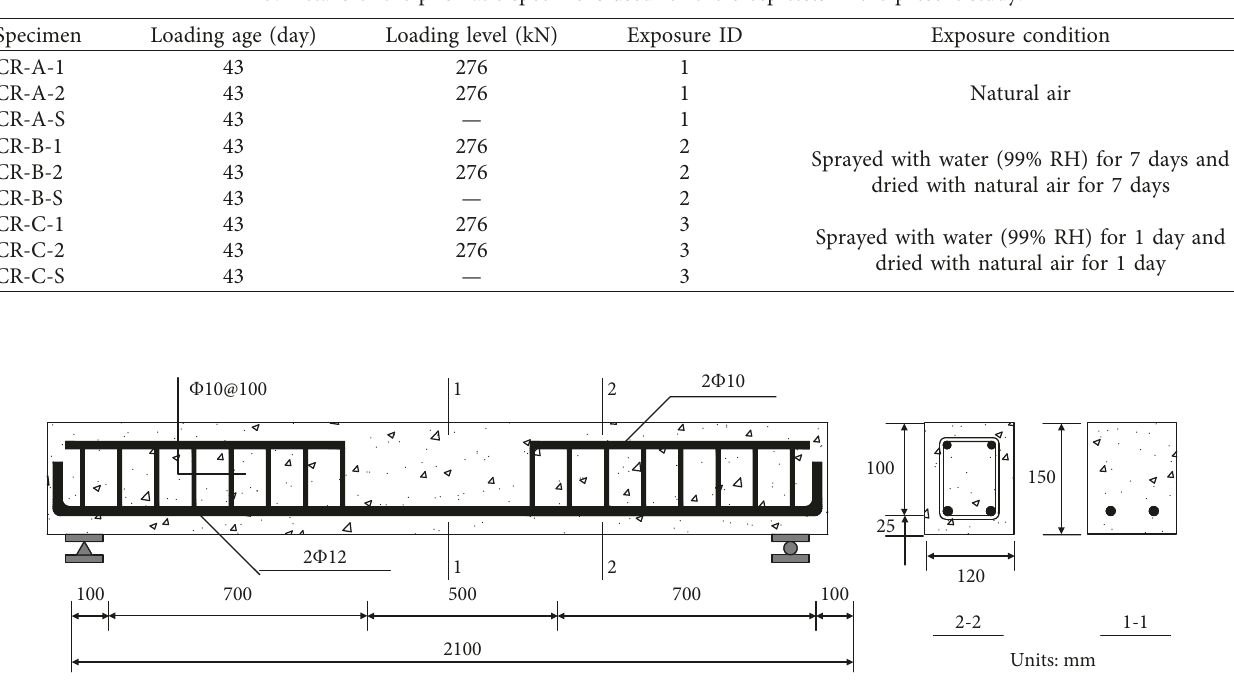
Table 3: Details of the prismatic specimens used for the creep tests in the present study.